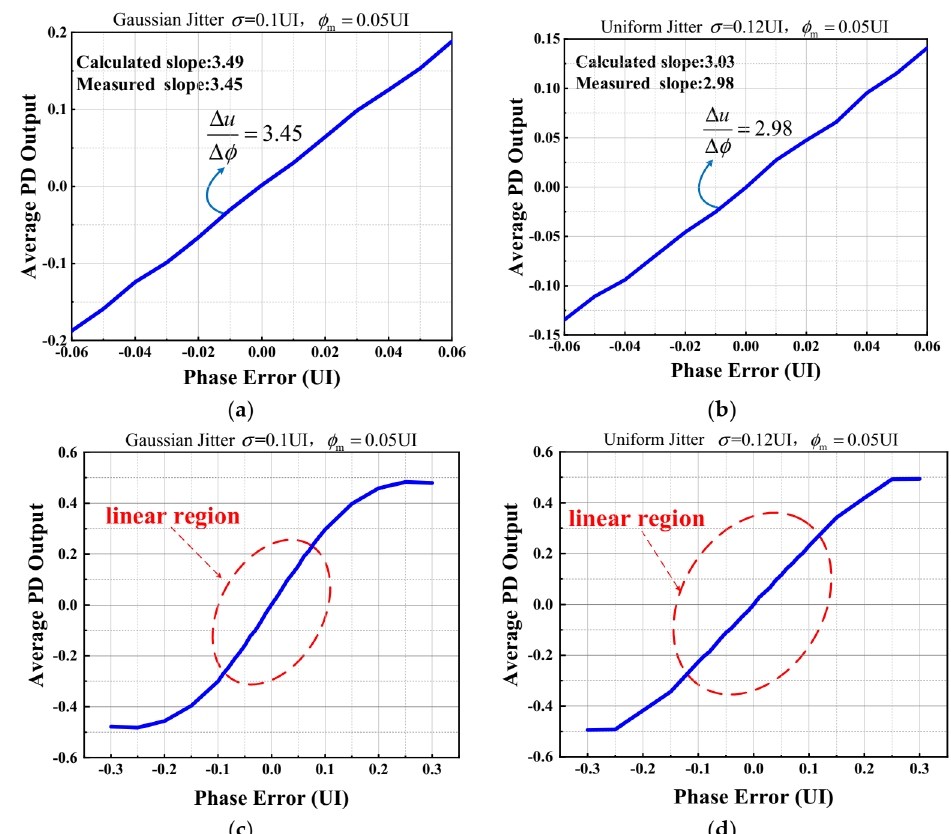
Figure 4. Simulated gain of MMPD. ( a ) Gaussian jitter at small phase difference, ( b ) uniform jitter at small phase difference, ( c ) Gaussian jitter at large phase difference, and ( d ) uniform jitter at large phase difference.